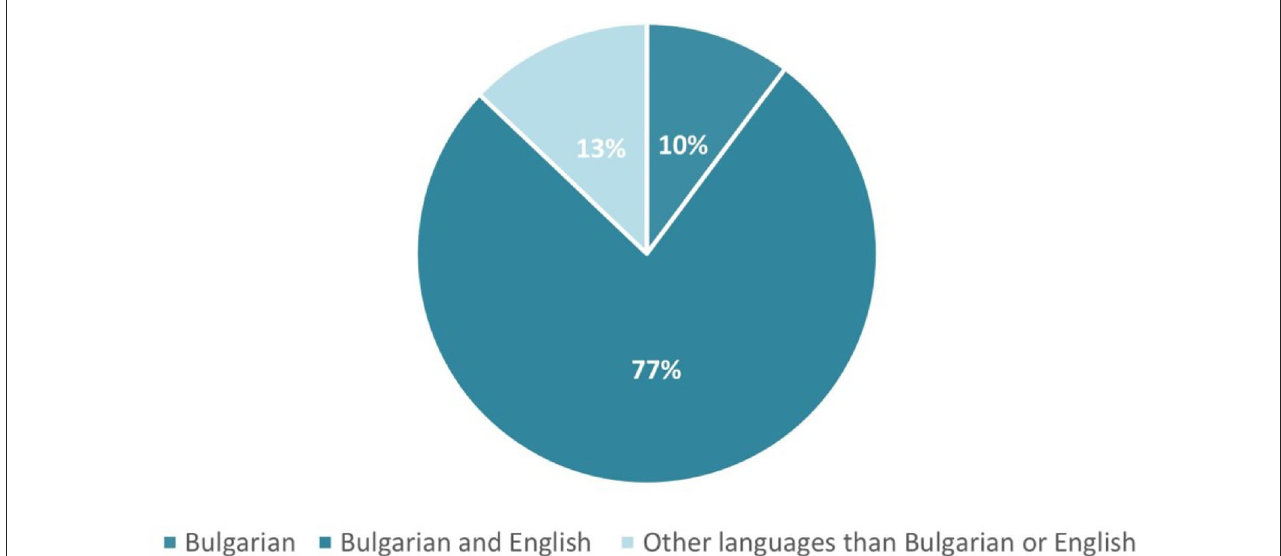
FIGURE6 Language/s of the sources used for searching information on coronavirus and related health topics by the